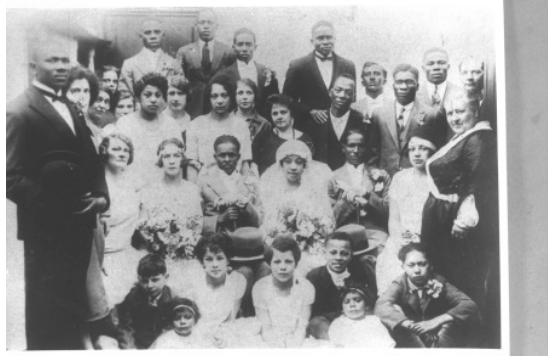
Figure 11. Unknown family, c. 1916. Image courtesy of Butetown History & Arts Centre. The Centre hosts a vast archive detailing the lives of Butetown residents, many of whom were in and from mixed-race families.